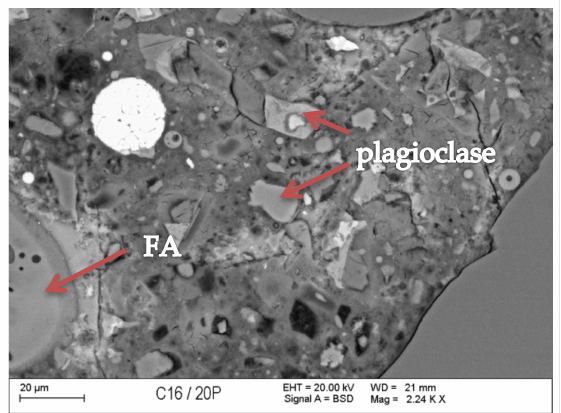
Figure 14. BSE image of FA concrete sample.